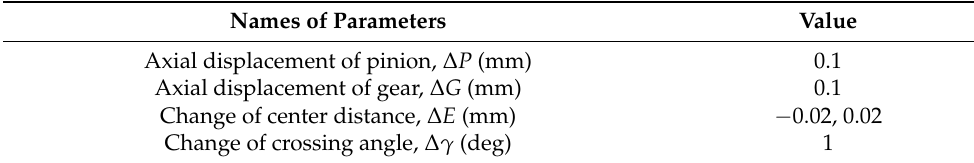
Table 3. Values of alignment